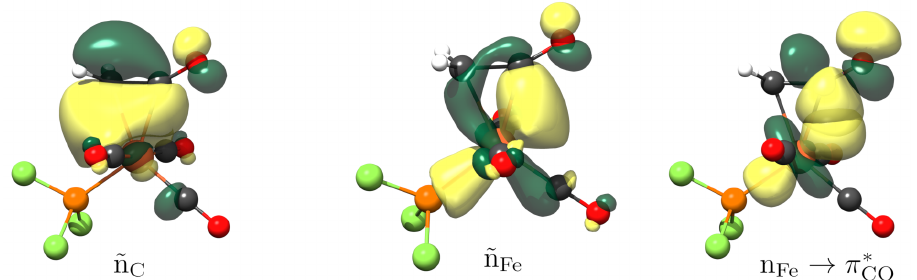
Figure 9. Natural localized molecular orbitals (NLMOs) for the leading donating interaction (left), and for the leading back-donating interaction (middle). On the right side, the dominant interaction of the NBOs for the back-donation is depicted.